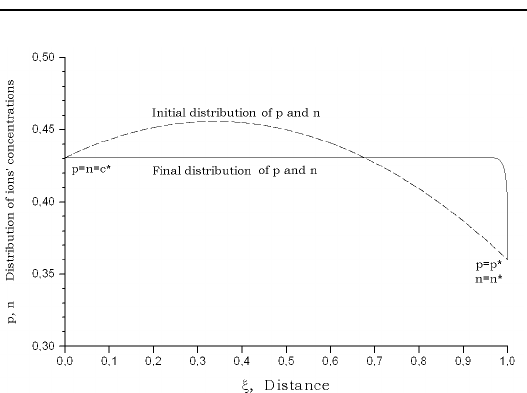
Figure 1. The steady state distribution: p ∗ = n ∗ , but p ∗ (cid:54) = c ∗ , n ∗ (cid:54) = c ∗ . The curves p = p ( ξ ) and n = n ( ξ ) coincide with each other.